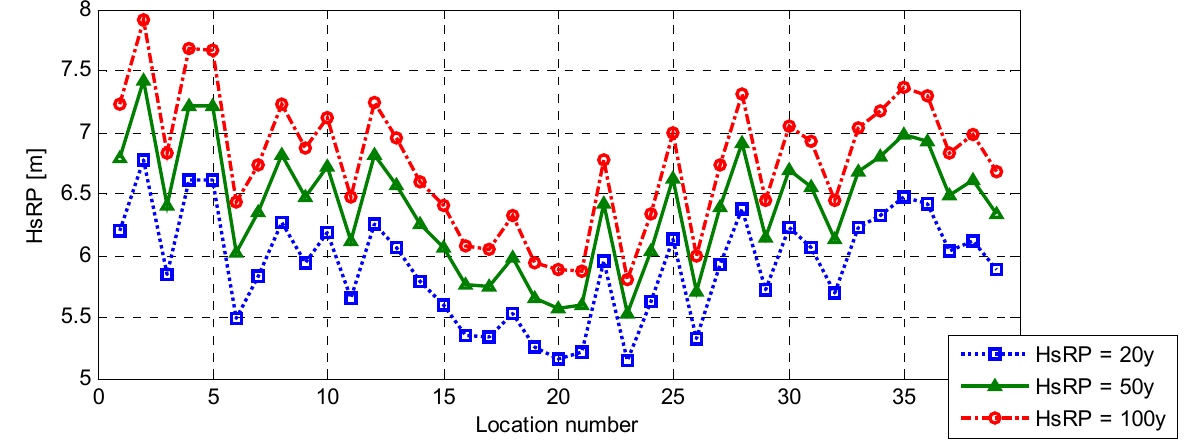
Figure 16. Most probable extreme significant wave height for RP = 20, 50 and 100 y per location.